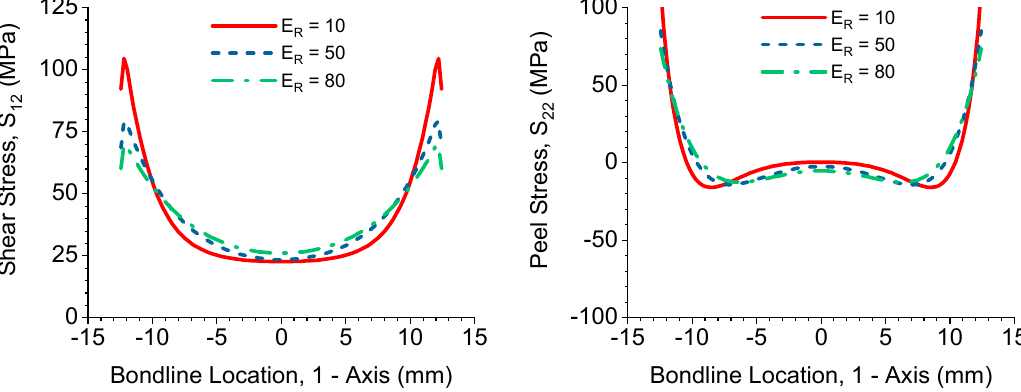
Figure 10. Shear stress and peel stress distributions along the bondline in a single-lap shear geometry for different modulus ratios, 𝐸 (cid:3045) .